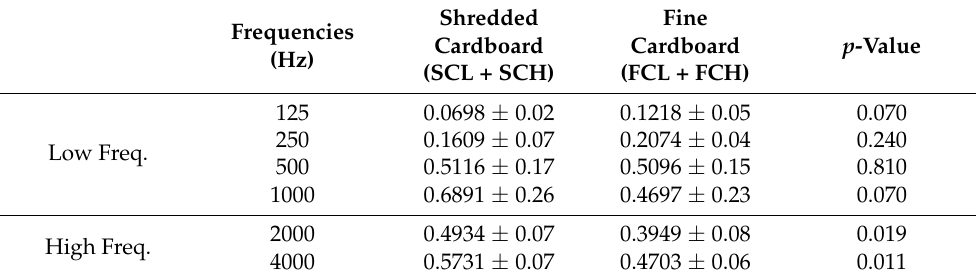
Table 4. Soundabsorptioncoefficientsofshreddedandfinecardboardsamples(mean ±